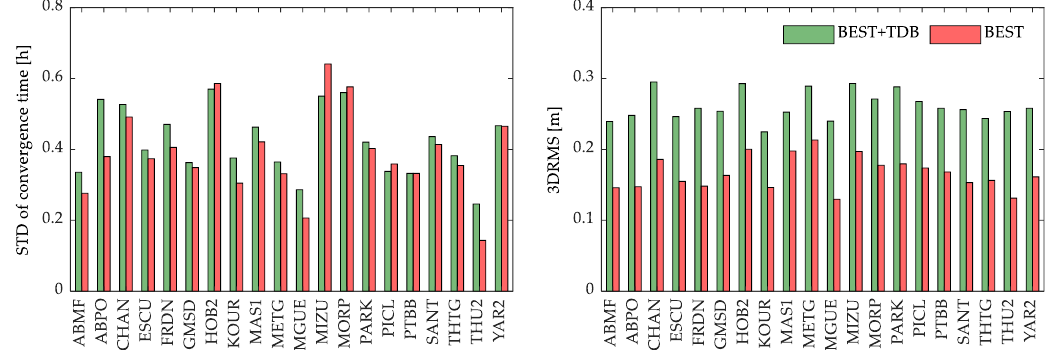
Figure 7. PPP results for the BEST and BEST + TDB at 20 arbitrary stations for one year. The two subplots on the left show the STD of the convergence time. The two subplots on the right show the 3DRMS of the positioning accuracy after convergence.